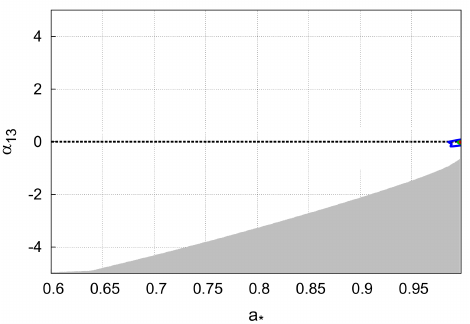
Figure 6. Constraints on the spin parameter a ∗ and the Johannsen parameter α 13 from the study in Ref. [62] of NuSTAR data of GS 1354–645. The red, green, and blue lines indicate, respectively, the 68%, 90%, and 99% confidence level curves for two relevant parameters. The grayed region is ignored because those spacetimes violate the constraint in Equation